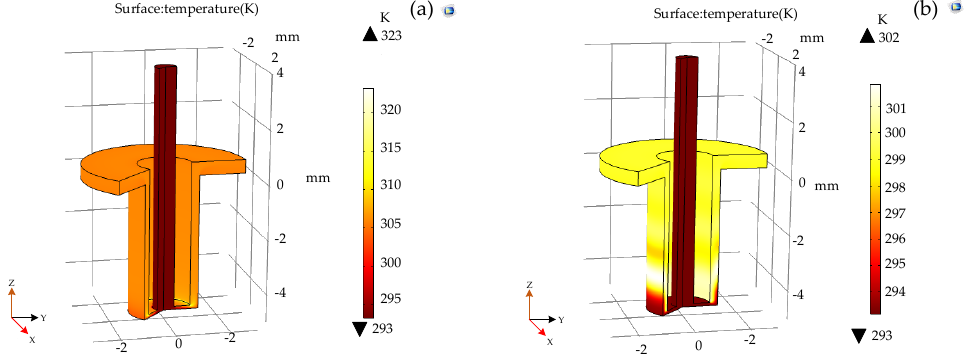
Figure 4. Temperature profile, ( a )DC voltage and ( b )pulse voltage.